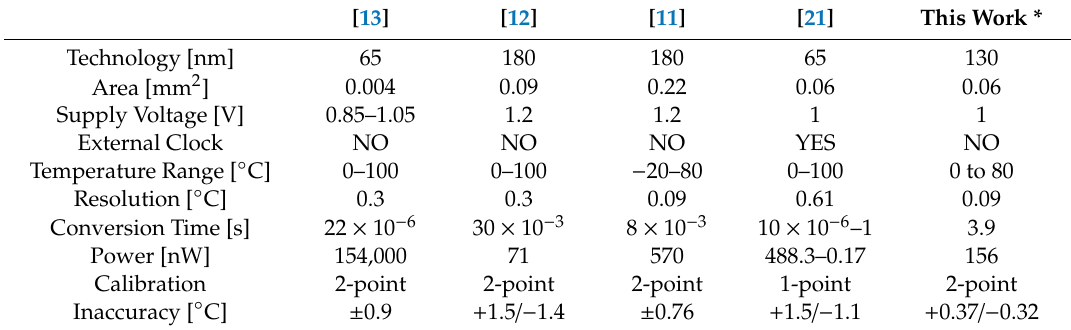
Table 1. Summarizes the performance of the proposed Table 1. S ummarizes the performance of the proposed sensor.